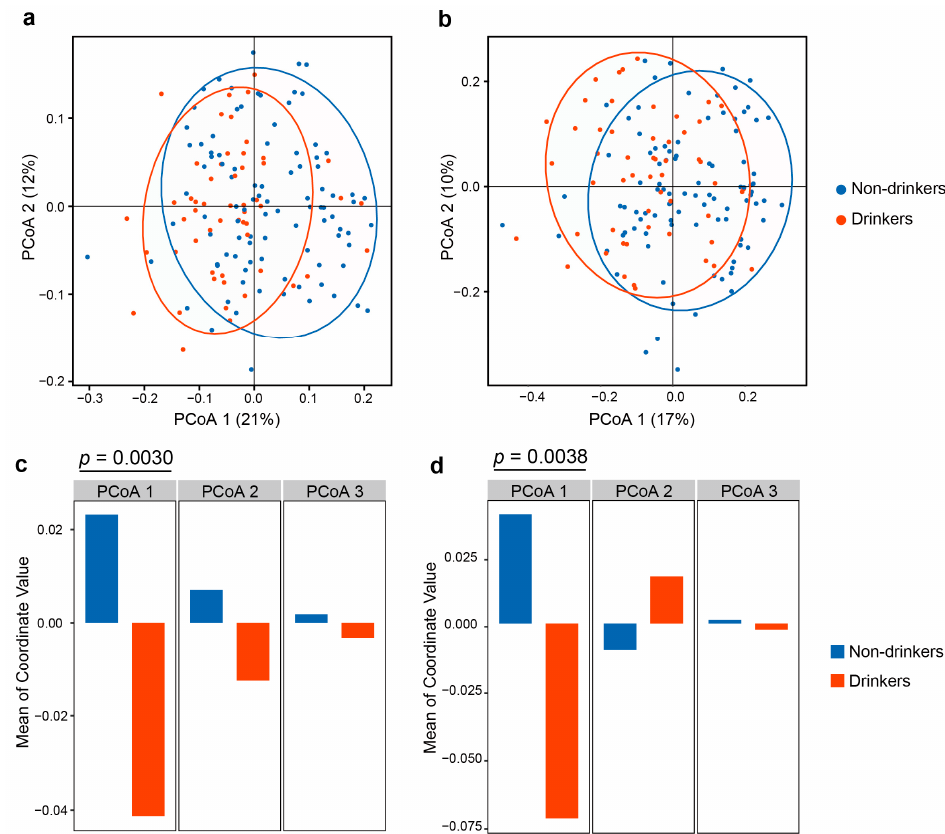
Figure 2. Beta diversity estimates of the oral microbial community. a, b PCoA based on ( a ) weighted UniFrac distance matrix and ( b ) Bray–Curtis distance matrix of the oral microbial communities between non-drinkers and drinkers. ( c , d ) Bar plots showing the means of the first, second, and third coordinates of PCoA for non-drinkers and drinkers using ( c ) weighted UniFrac and ( d ) Bray–Curtis distance matrix. p values were calculated by the linear regression model with controlling age, sex and smoking status. Table 2. The differential bacterial taxa between non-drinkers and drinkers at genus and species